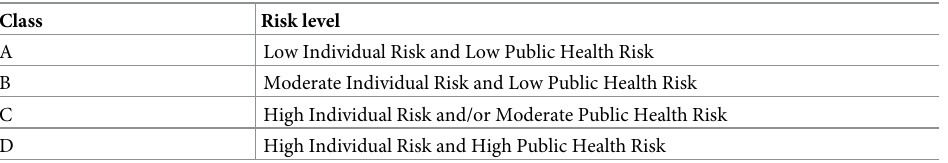
Table 1. Risk classification system for